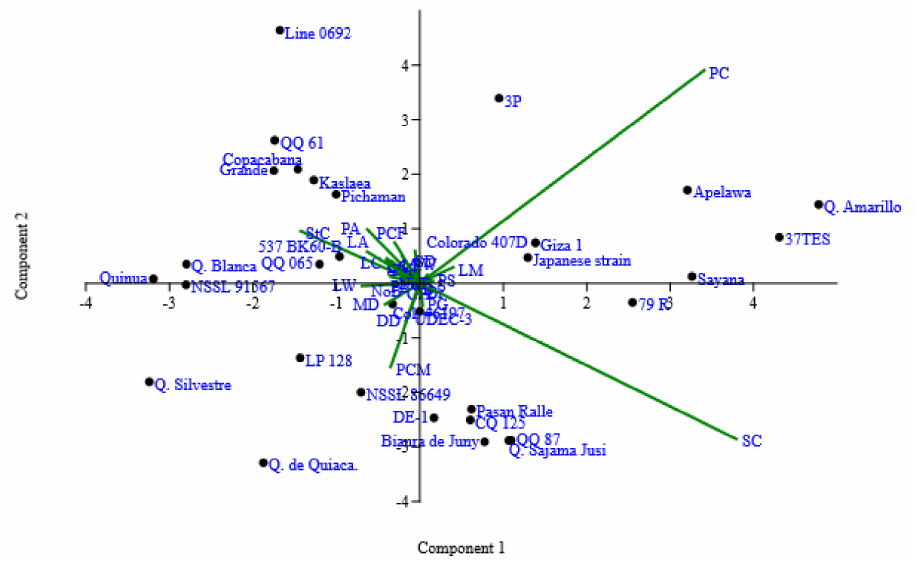
Figure 2. Two-dimensional ordination of the qualitative and rescaled quantitative data traits in quinoa genotypes. Component 1 represented 37.9%, and component 2 represented 27.3% of the total